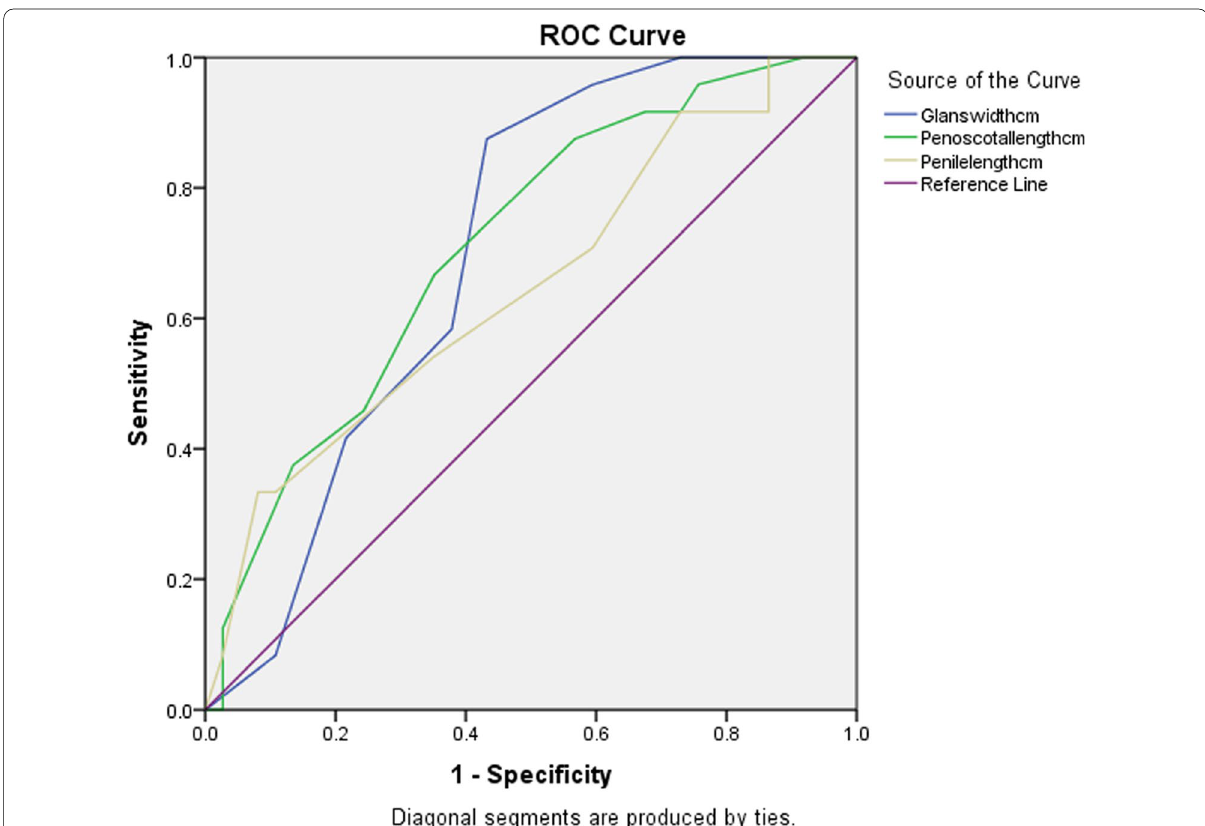
Fig. 3 ROC curve of glans width, penoscrotal length, and penile